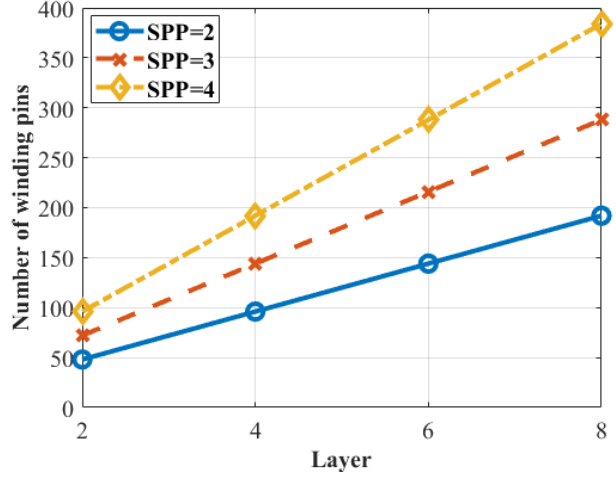
Figure 18. Total number of hairpin windings as a function of SPP value and number of conductor layers.